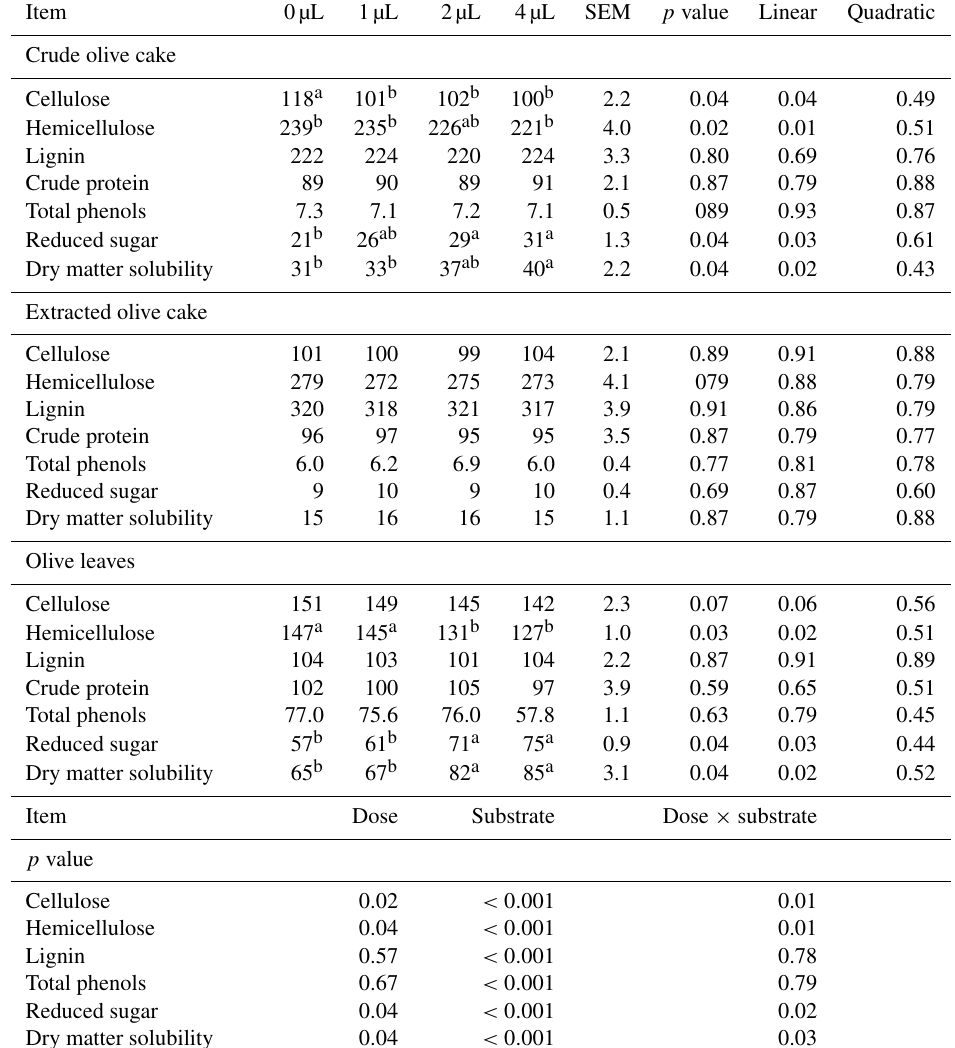
Table 2. Influence of exogenous fibrolytic enzymes on chemical composition of olive mill waste after pre-incubation. Item 0µL 1µL 2µL p value Linear Quadratic Crude olive cake Cellulose